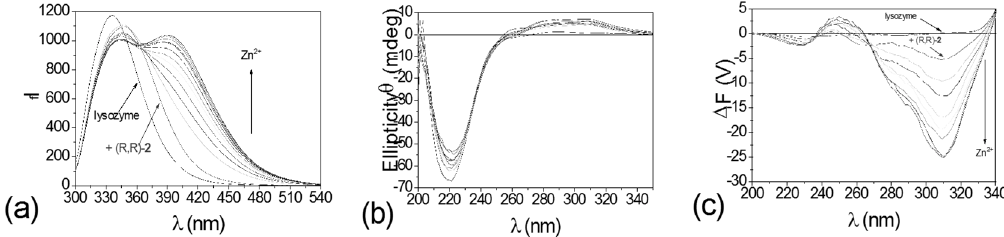
Figure 16. Spectral responses of 3.2 µM ( R , R )- 9 to Zn 2+ at the presence of 1.0 mg/mL hen egg white (HEW) lysozyme in 60% acetonitrile/water. ( a ) Fluorescence (Ex: 280 nm); ( b ) CD; and ( c ) Δ F [52]. Reprinted with permission from Reference [52]. Copyright (2004) American Chemical Society.